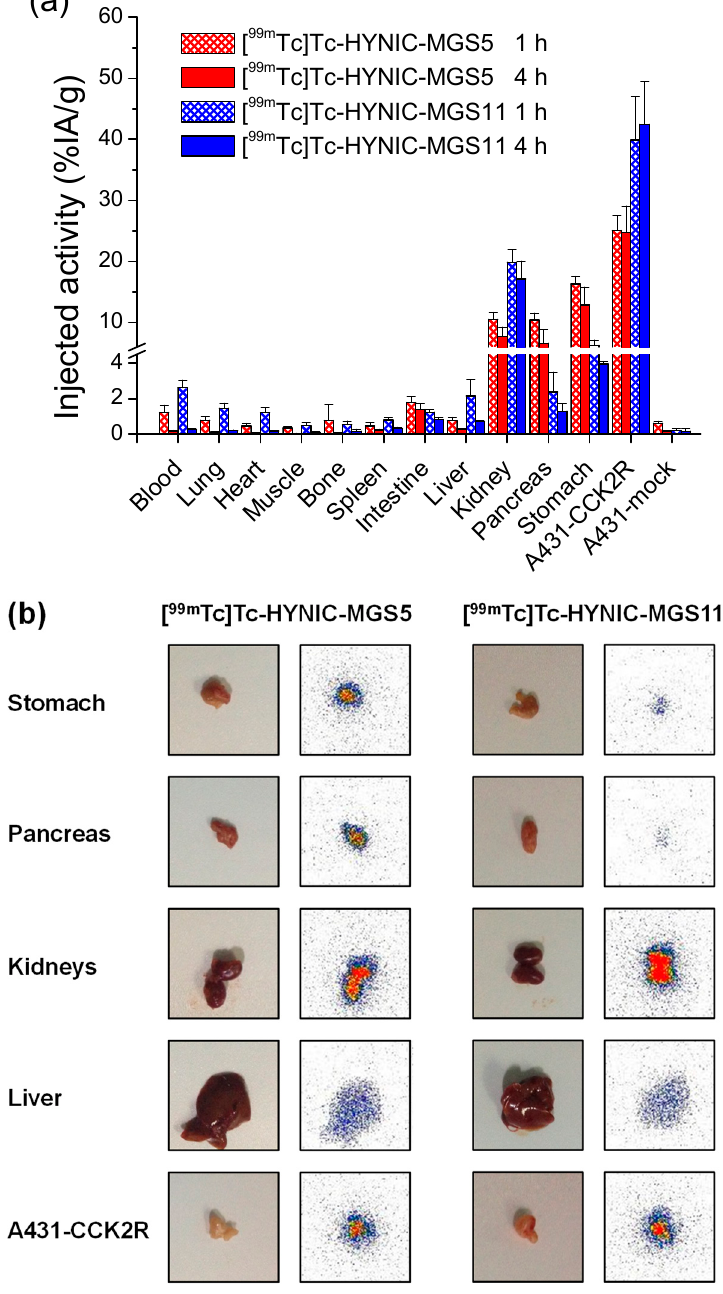
Figure 7. Biodistribution of [ 99m Tc]Tc ‐ HYNIC ‐ MGS5 (red) and [ 99m Tc]Tc ‐ HYNIC ‐ MGS11 (blue) in the A431 ‐ CCK2R/A431 ‐ mock xenograft model: ( a ) tissue distribution and tumor uptake at 1 h and 4 h p.i. with values expressed as % IA/g (mean ± SD, n = 4); ( b ) autoradiography performed for selected organs at 1 h p.i. (color scale, pixel intensity: min 9 (blue), max 100 (red)).